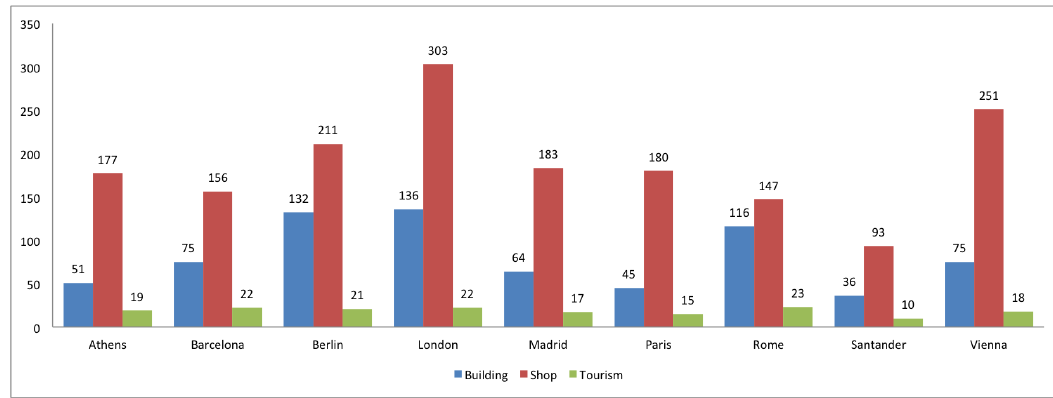
Figure 28. Richness study in Europe. Number of distinct categories.